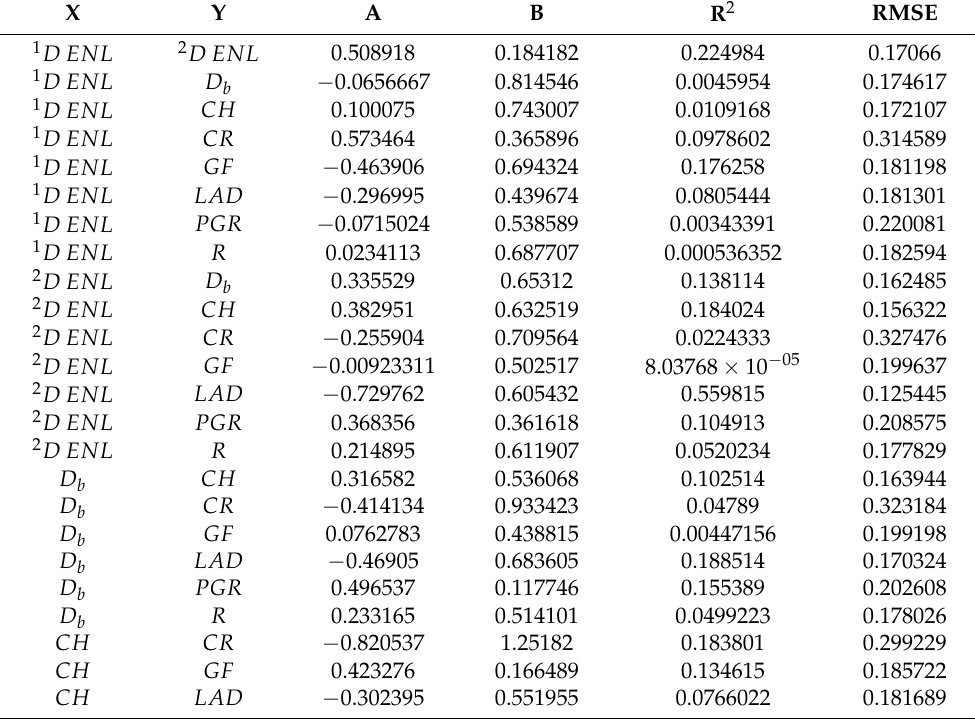
Table A17. Overview of ULS linear regression at 5m grid